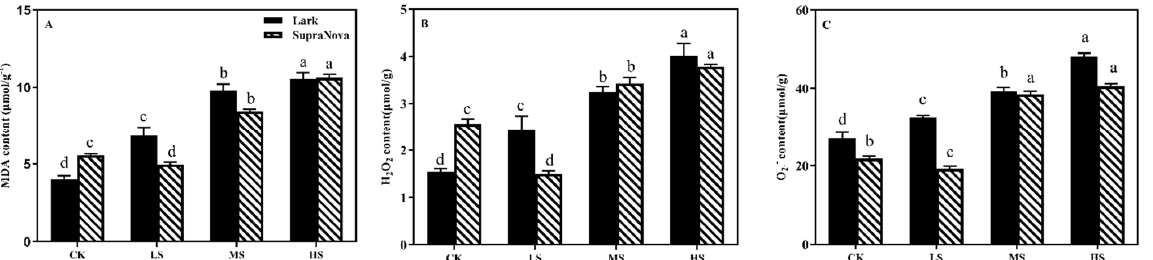
Figure 5. MDA, H 2 O 2 , and O 2 · − contents of two species under different shade treatments ( A – C ). The lowercase letters denote significant differences ( p < 0.05) for the same species. CK = unshaded; LS = 35% shaded; MS = 70% shaded; HS = 92% shaded. The black box represents the species ‘Lark’ and the striped box represents the species ‘SupraNova’.